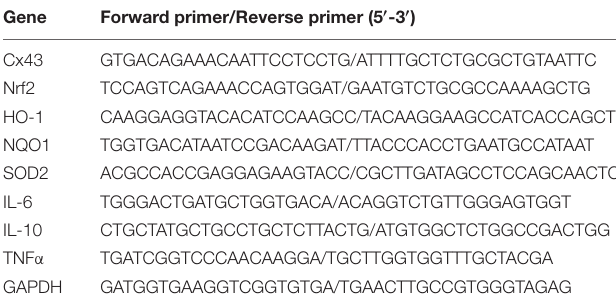
TABLE 1 | Primer sequences for qRT-PCR.